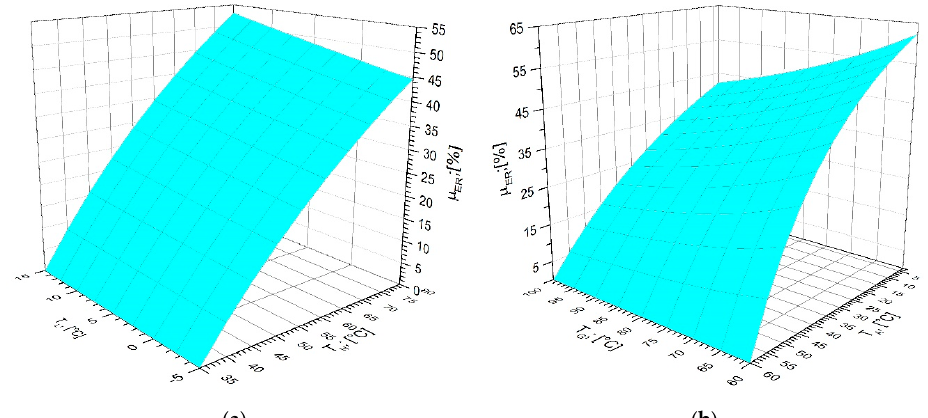
Figure3. Thermo-chemicalinstabilityofdouble-useabsorptionmachines( a )asafunctionofevaporation Figure 3. Thermo-chemical instability of double-use absorption machines ( a ) as a function of temperature and condensation temperature, and ( b ) as a function of absorber temperature and evaporation temperature and condensation temperature, and ( b ) as a function of absorber generator temperature. temperature and generator temperature.